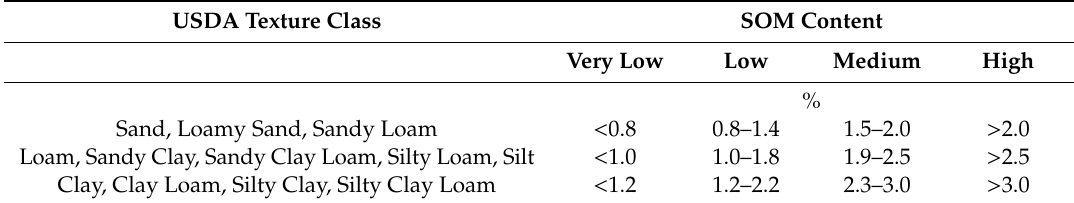
Table 1. Levels defined for Soil Organic Matter (SOM) evaluation based on USDA (United States Department of Agriculture) textural classes